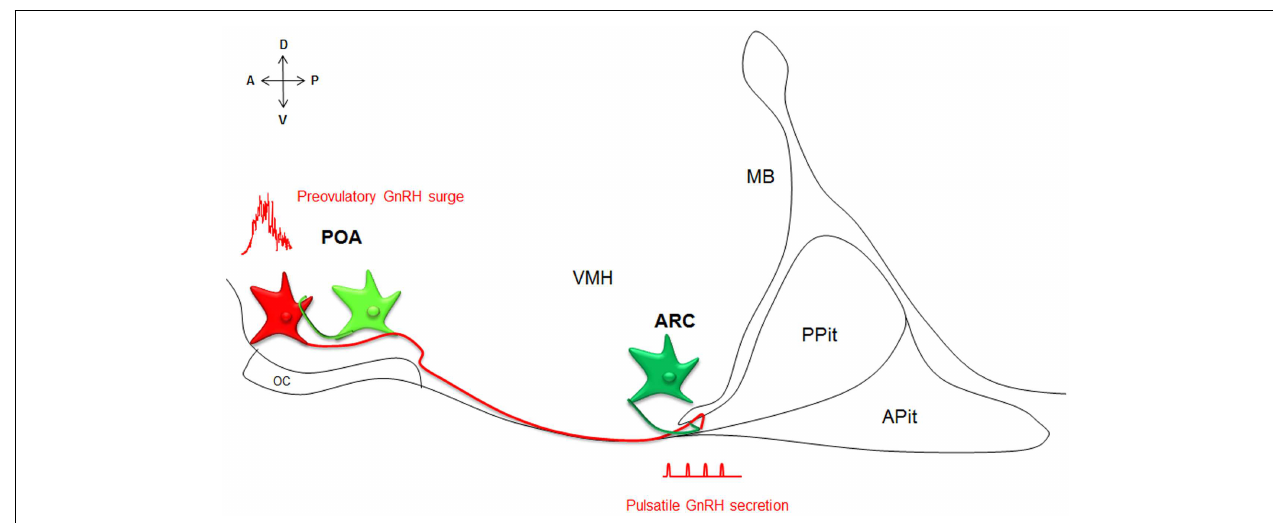
kisspeptin cells in the ARC modulate the tonic pulsatile release of GnRH. Both populations of kisspeptin neurons interact with GnRH neurons in part directly. A, anterior; P, posterior; D, dorsal;V, ventral; POA, preoptic area; ARC, arcuate nucleus; OC, optic chiasm,VMH, ventromedial hypothalamus; MB, mammillary bodies; APit, anterior pituitary; PPit, posterior